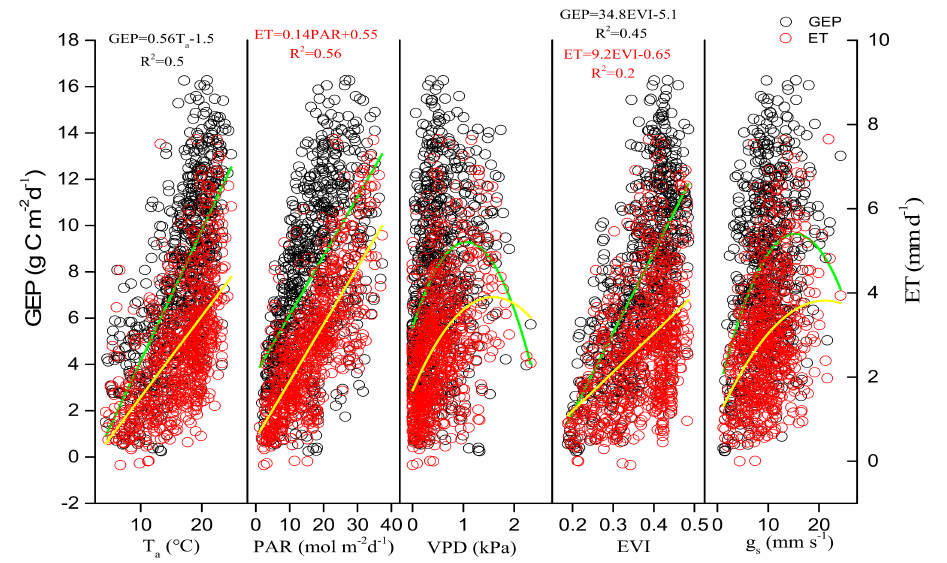
Figure 8. Relationships of daily gross ecosystem productivity (GEP), evapotranspiration (ET) with daily environmental factors (T a , PAR, VPD) and biological factors (EVI, midday g s ) in all of the growing seasons from 2017 to